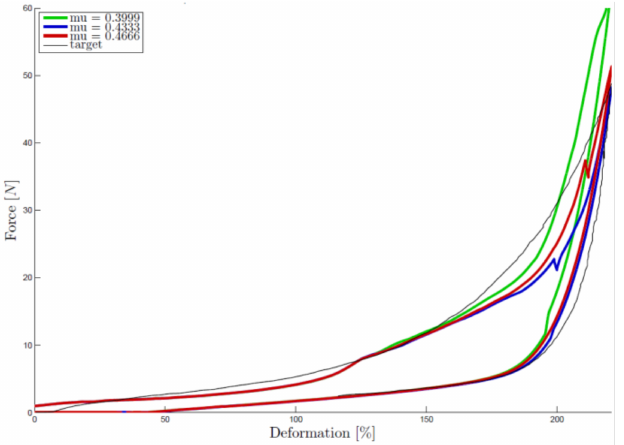
Figure 2. Comparison of simulation results (colored plots) and experimental data (black plot) for loading-unloading of weft knitted textile sheet. Varying friction coefficient µ